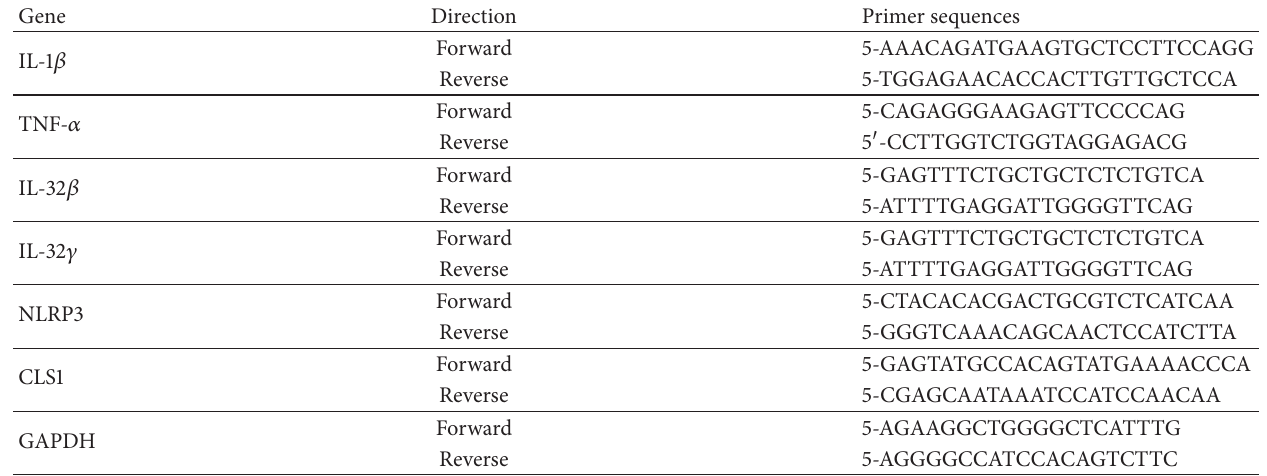
Table 1: Primer sequences of the genes tested in this